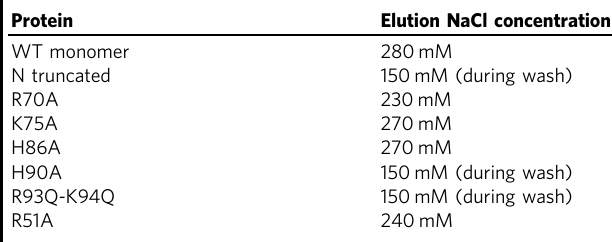
Table 2 Comparison of WT and mutant cystatin C binding to heparin – Sepharose column at pH 5.5.